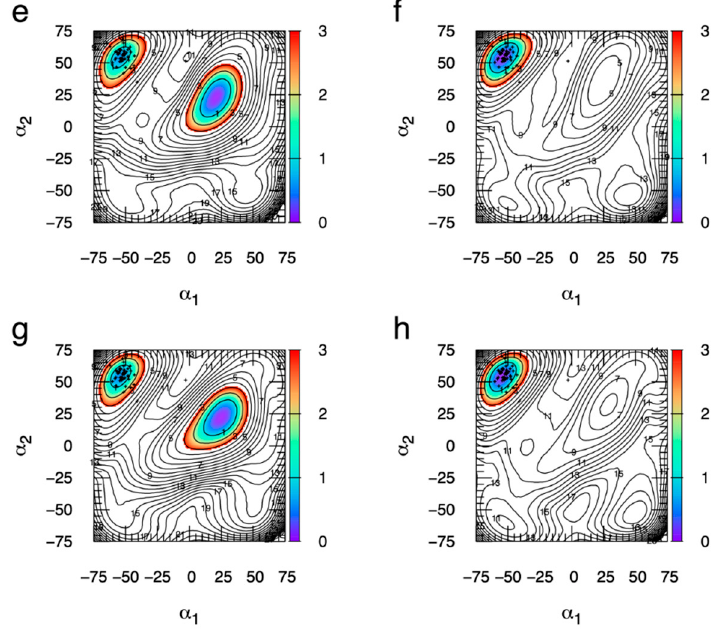
Figure A1. ∆ G ( α 1 , α 2 ) from eABF simulations using incorrect versus correct dihedral force field parameters for Neu5Ac along with ( α 1 , α 2 ) data from all Neu5Ac structures in the PDB (searched 30 July 2021). ∆ G ( α 1 , α 2 ) contour data are for α Neu5Ac with incorrect parameters ( a ), α Neu5Ac with correct parameters ( b ), Me α Neu5Ac with incorrect parameters ( c ), Me α Neu5Ac with correct parame- ters ( d ), β Neu5Ac with incorrect parameters ( e ), β Neu5Ac with correct parameters ( f ), Me β Neu5Ac with incorrect parameters ( g ), and Me β Neu5Ac with correct parameters ( h ). α 1 and α 2 are in degrees. ∆ G ( α 1 , α 2 ) is from the first simulation in the triplicate and is in kcal/mol, with contours drawn every 1 kcal/mol and colored from 0–3 kcal/mol. PDB data were divided into two groups: those from α anomers and those from β anomers. Crystallographic data from the α anomers are displayed as small +’s in ( a – d ) and crystallographic data from the β anomers are displayed as small +’s in ( e – h ). For the β anomers simulated using the incorrect parameters ( β Neu5Ac (Figure A1e) and Me β Neu5Ac (Figure A1g)), there are no crystallographic Neu5Ac structures in the β anomeric form that coincide with the global minimum. In contrast, with the correct parameters, nearly all of these crystallographic structures in the β anomeric form, which are in the 2 C 5 chair pucker conformation, coincide with the global ∆ G ( α 1 , α 2 ) minimum for both β Neu5Ac (Figure A1f) and Me β Neu5Ac (Figure